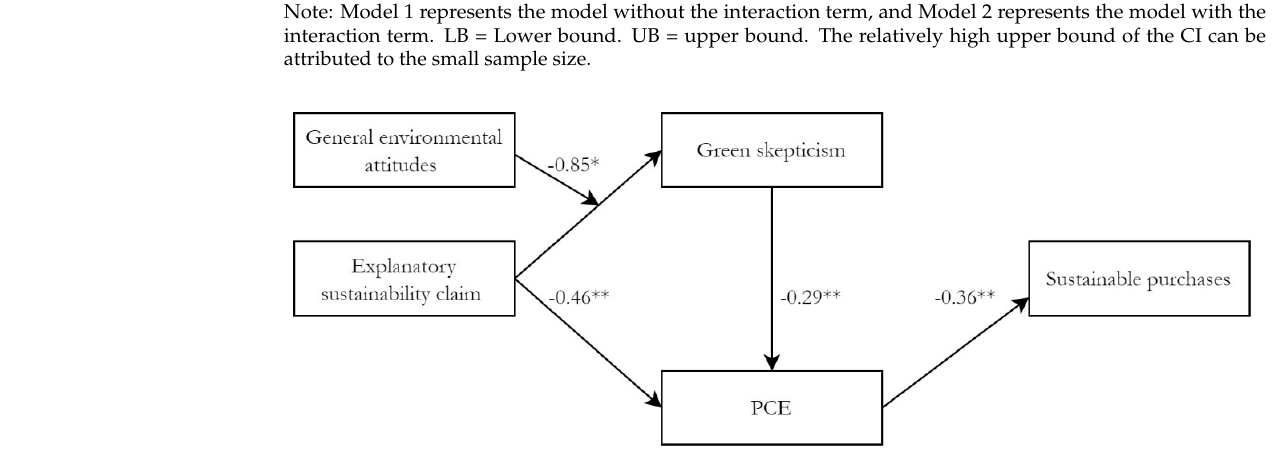
Figure 3. Final path model to test H3c (Model 2). Note: ** Relationship is significant at the 0.01 level. * Relationship is significant at the 0.05 level. Unstandardized coefficients are reported. Model fit: χ 2df=4 = 2.89, p = 0.576, CFI = 1.00; RMSEA = 0.00, 90%CI = [0.00, 0.13], PCLOSE = 0.684. Table 4. Re-specification steps and fit indices.